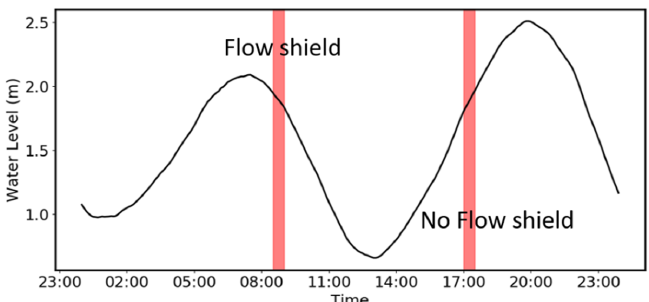
Figure 5. Tidal water level over the course of the field test on 30 August 2018. Highlighted regions indicate NoiseSpotter deployments with, and without the flow noise removal shield.